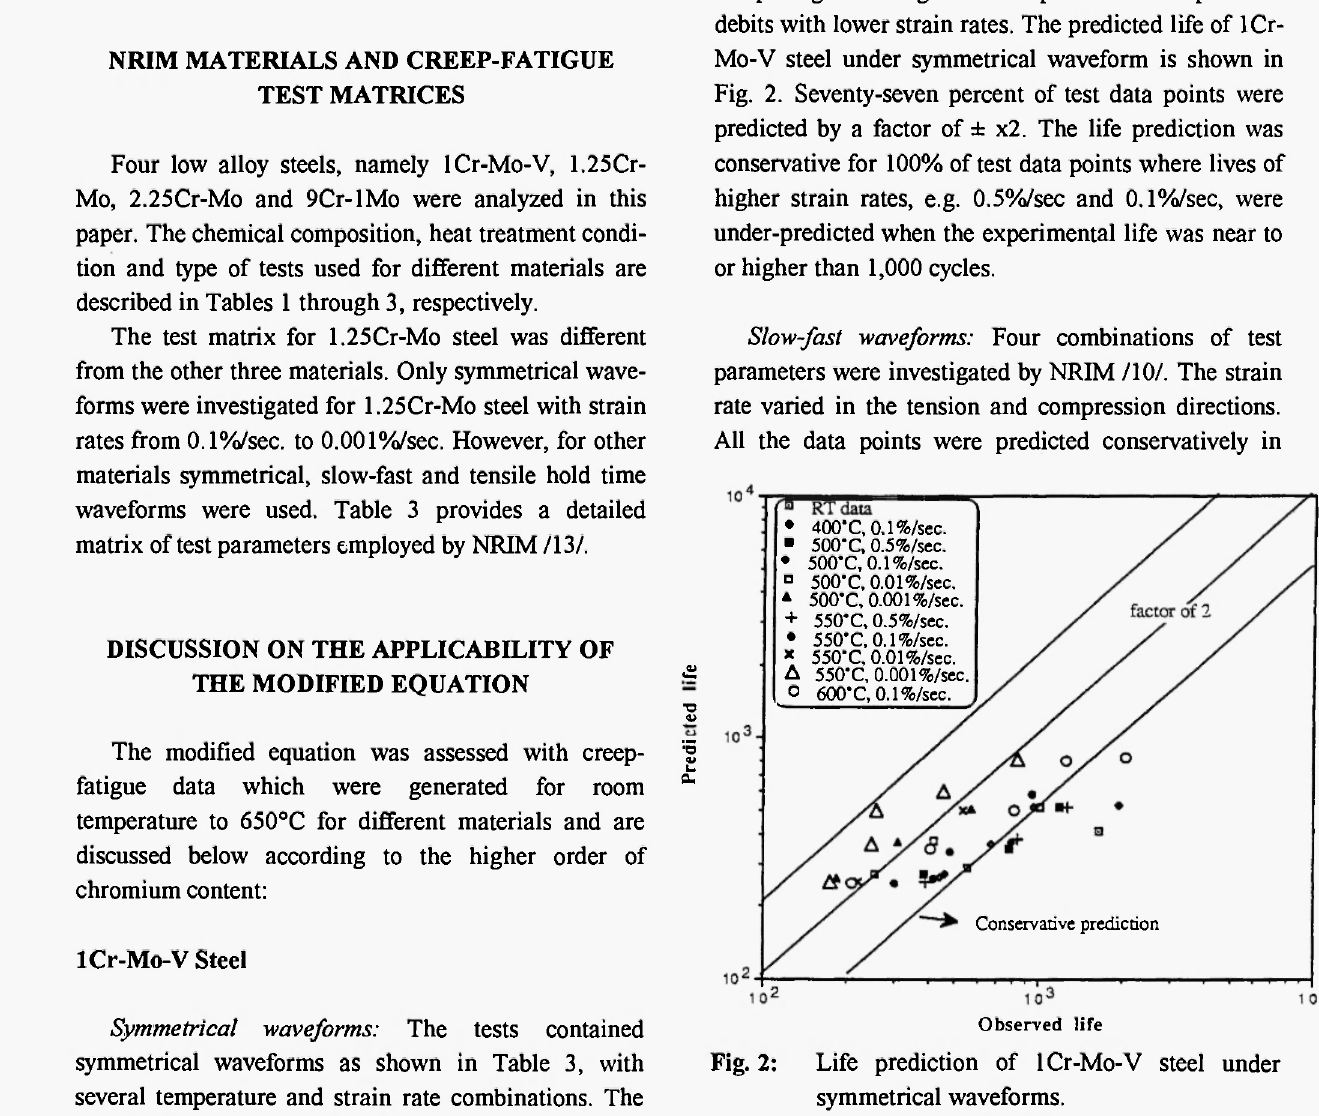
Life prediction of lCr-Mo-V steel under symmetrical